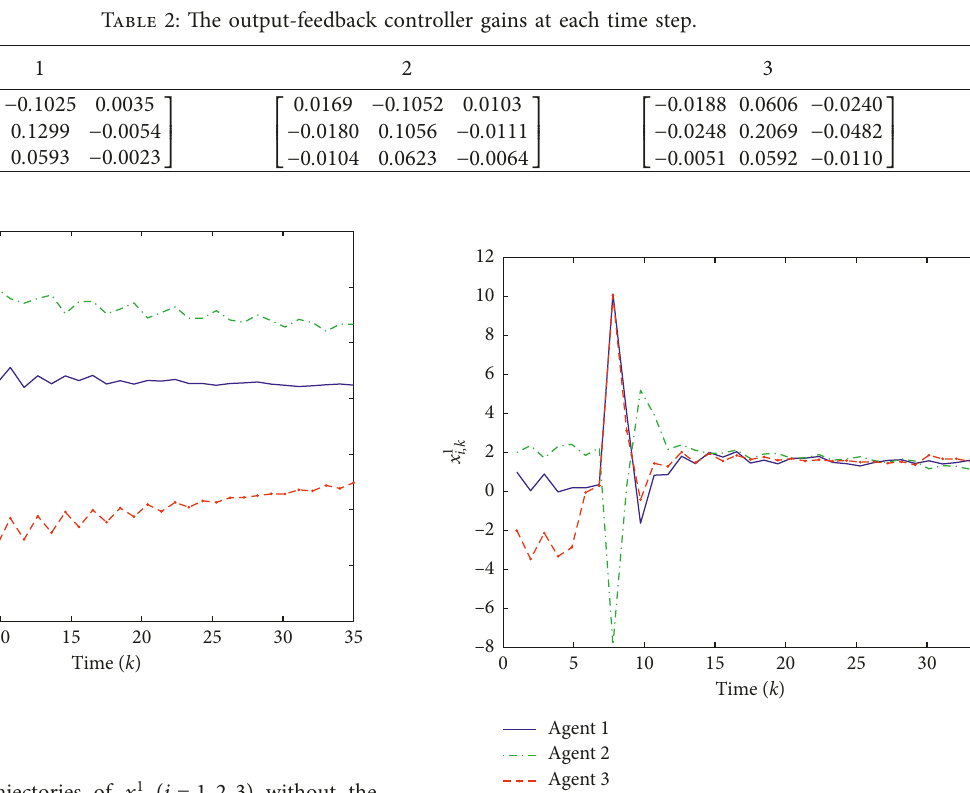
Figure 3: The state trajectories of x 1